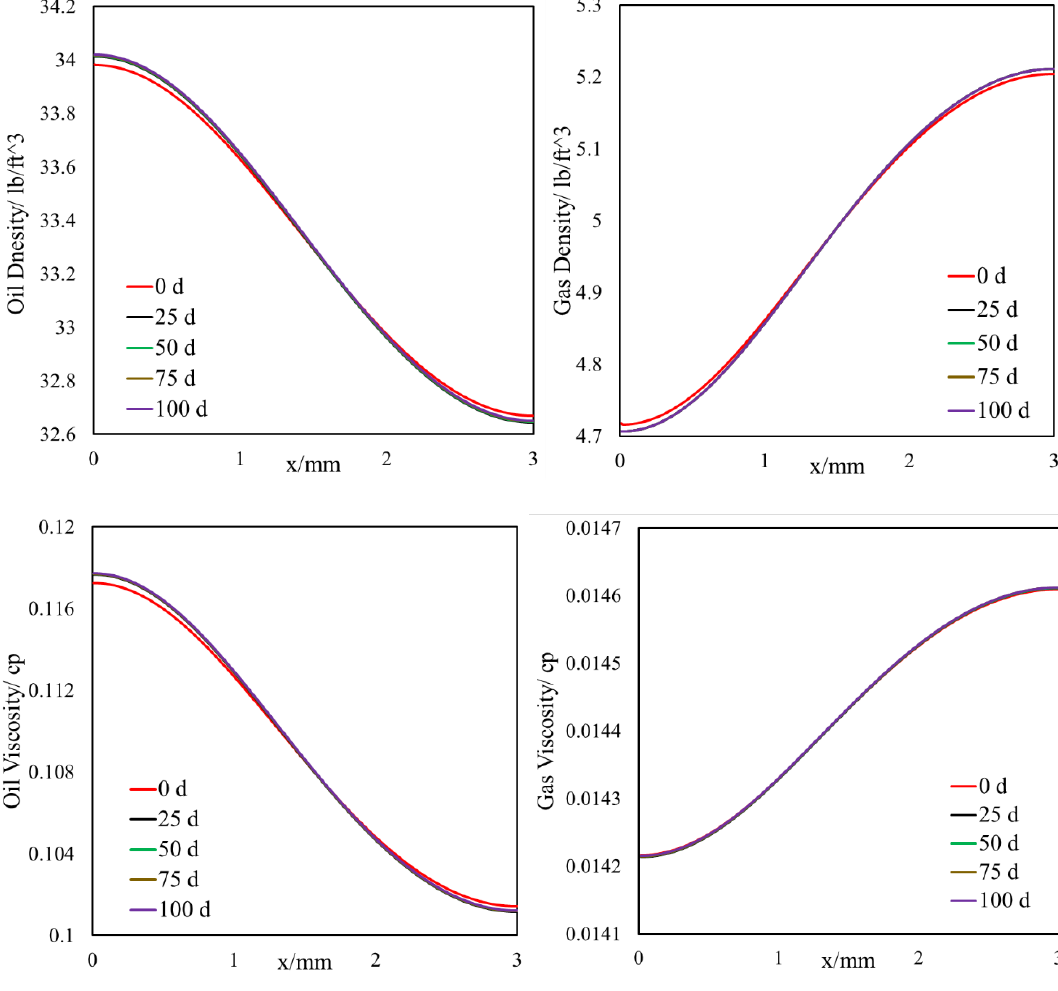
Figure 11. Oil and gas density/viscosity profile at different times, Marcellus shale condensate.